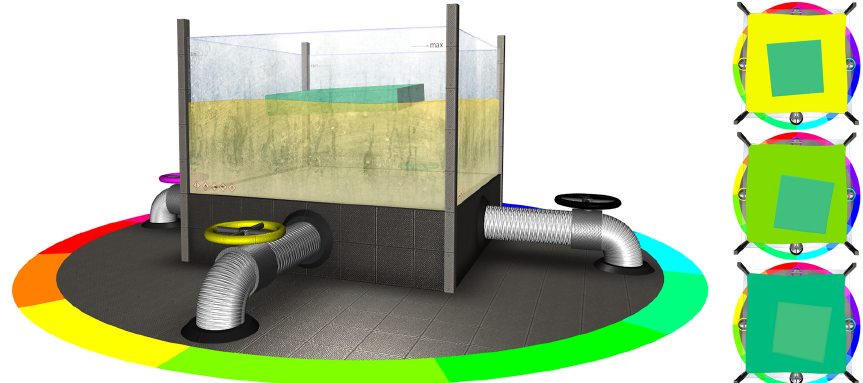
Figure 8. A snapshot of the CMY reservoir ( left ) and disappearing plate reaching a solution ( right ).